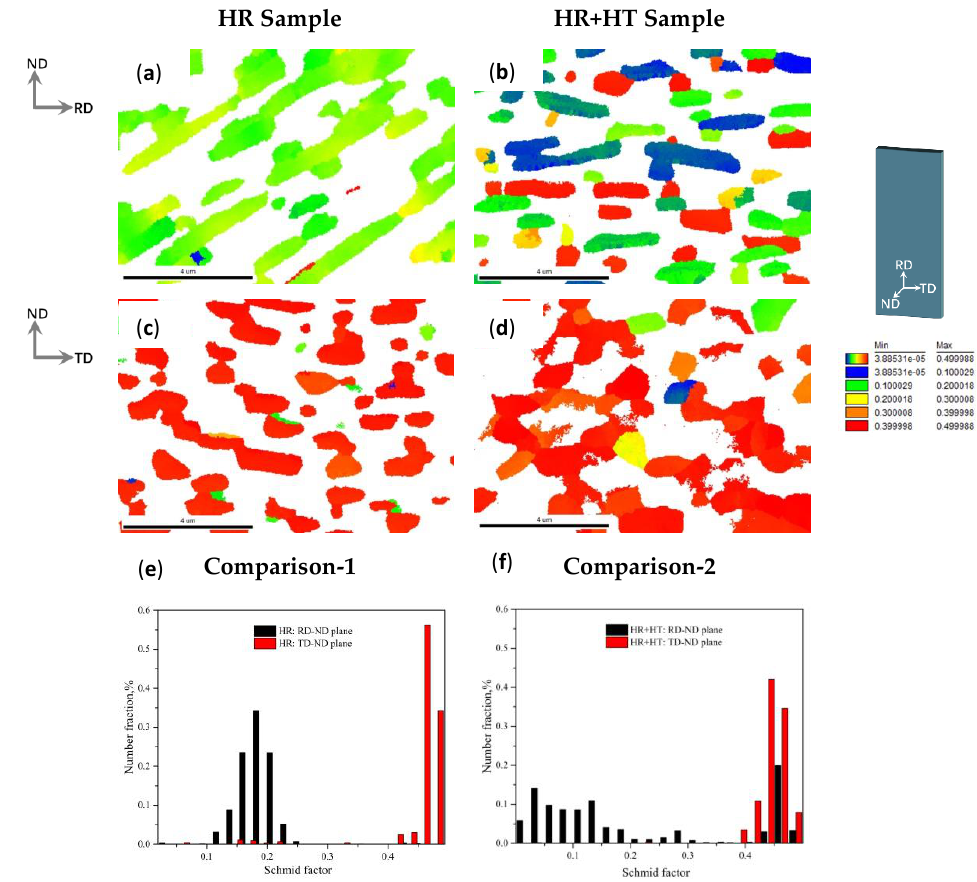
Figure 6. Schmid factor distributions of {0001}<11-20> slip system in α phase. ( a , b ): ND-RD plane; ( c , d ): ND-TD plane; ( e ): comparison of ( a ) and ( c ); ( f ): comparison of ( b ) and ( d ).